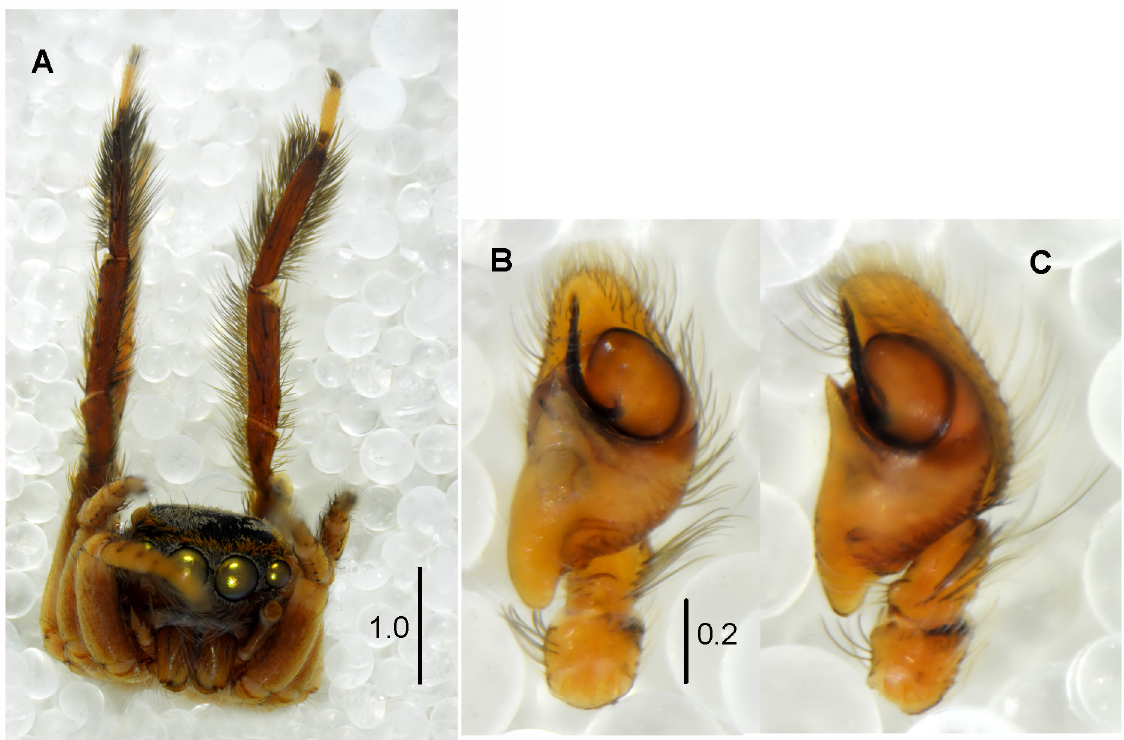
Fig. 59. Saitis barbipes (Simon, 1868), ♂ (MNHN). A . Frontal view. B . Palpal organ, ventral view. C . Palpal organ, ventrolateral view.